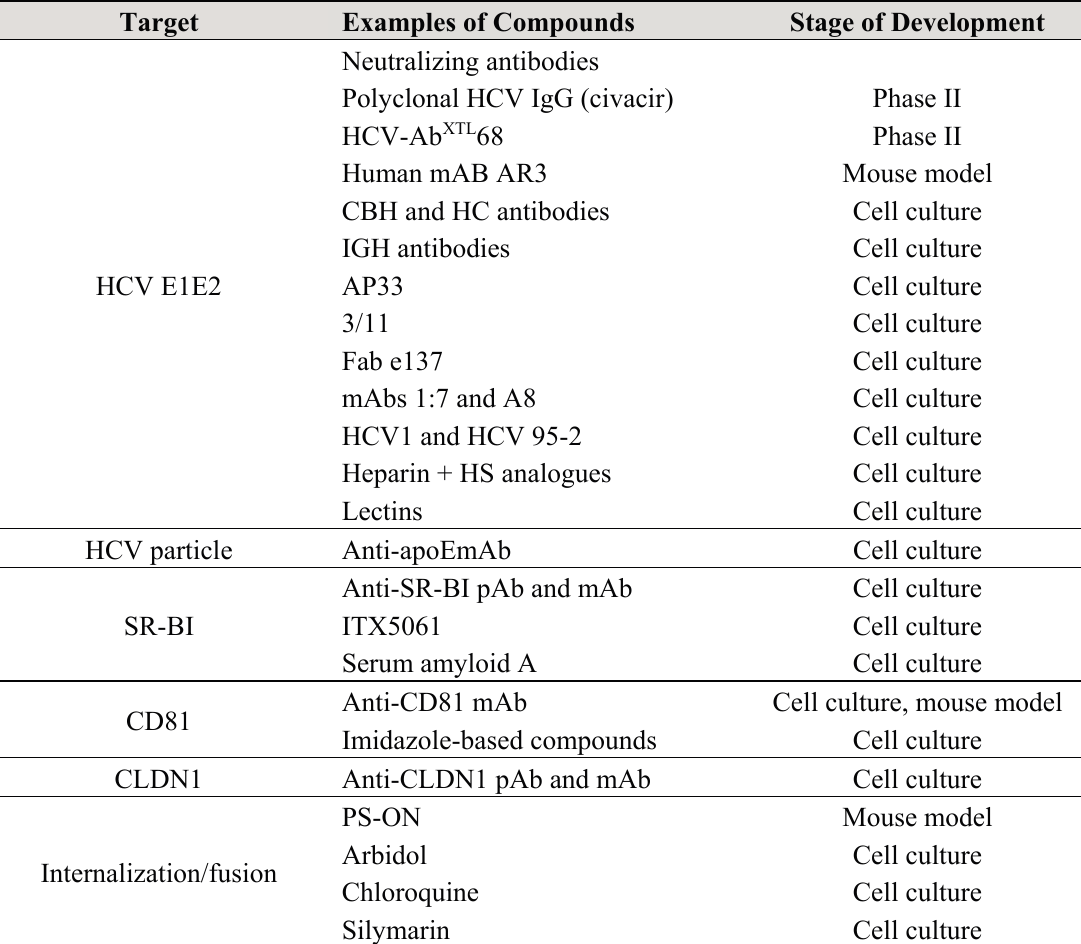
Table 2. New anti-hepatitis C virus (anti-HCV) compounds targeting viral entry and their stage of development